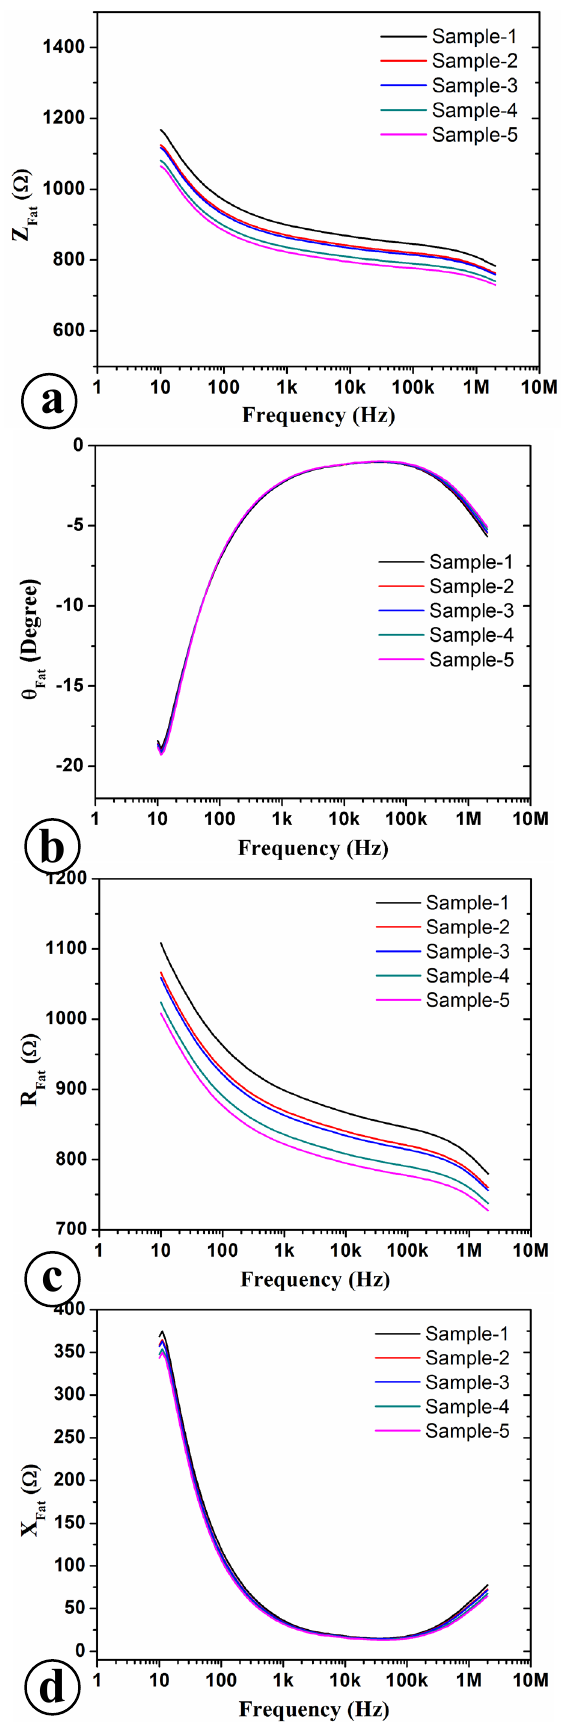
Figure-6: Variation of impedance parameters of chicken tissue over frequency: (a) Z Fat , (b) θ Fat , (c) R Fat , (d) X